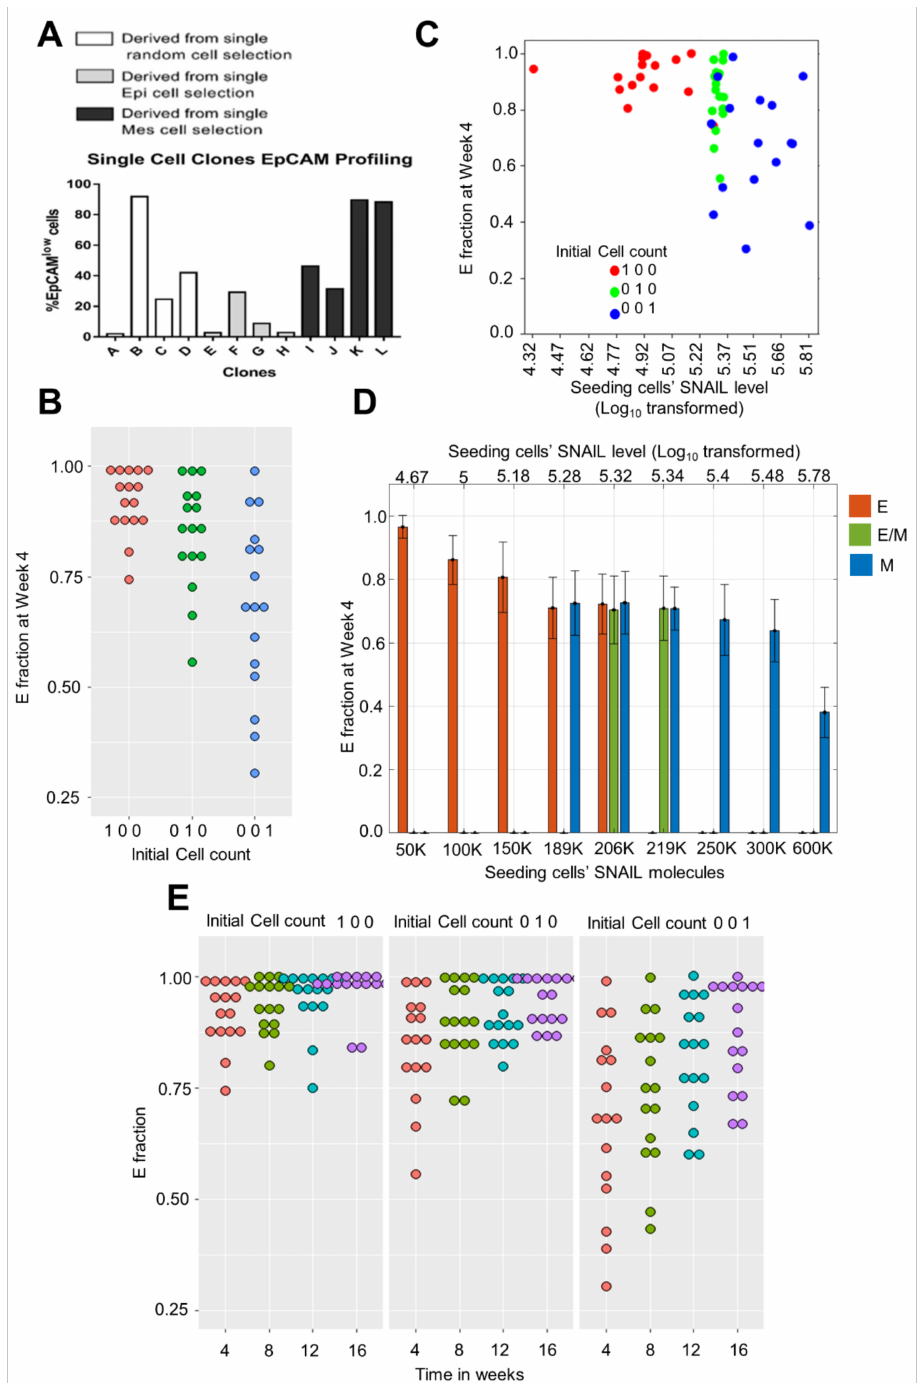
Figure 5. Heterogeneity in the E fraction among single cell clones at initial stages of culture. ( A ) Ex- perimentally observed heterogeneity in EpCAM profiling of single cell clones from PMC42-LA cells (adapted from Bhatia et al. J Clin Med [20]). ( B ) Variability in the E fraction observed on simulating population dynamics starting with single E, E/M and M cell. Each dot represents the E fraction at 4th week in an independent single cell simulation run. ( C ) E fraction in a single cell clone at 4th week plotted against the seeding (parent) cells’ SNAIL level. ( D ) Spread of the E fraction at 4th week of single cells clones when the seeding cells were initialised with certain SNAIL levels spanning mono-, bi-, and tri-stable regions of bifurcation diagram (Figure 4B). Mean and standard deviation calculated from 20 independent runs ( E ) Temporal dynamics extension of single cell simulation runs in ( B ). All results are with η 1 = 0.2 and η 2 = 0.1, and DT(E, E/M, M) = 20